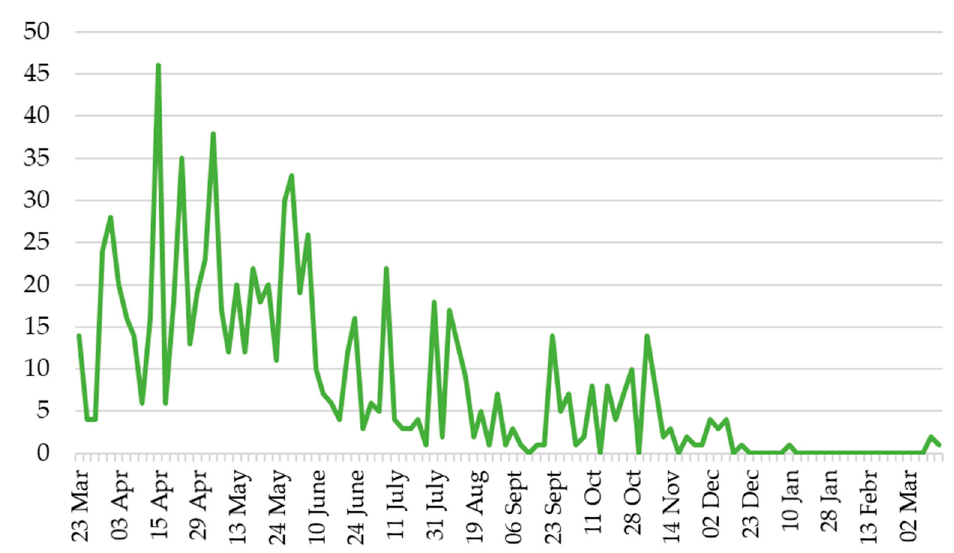
Figure 8. Trend of the biweekly oviposition (total number of eggs laid in fifteen days) performed by six Aclees taiwanensis couples over one year (March 2019–March 2020).